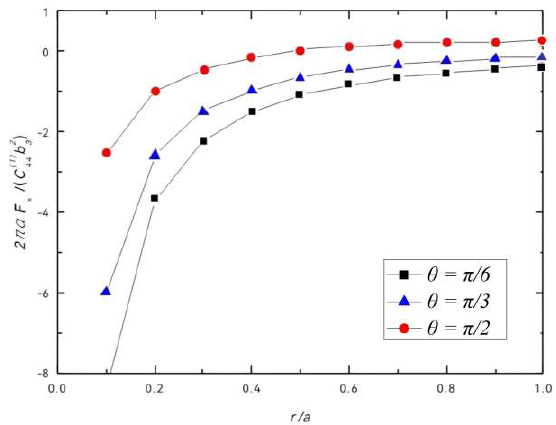
( 1 ) ) vs. r / a . b 2 3 44